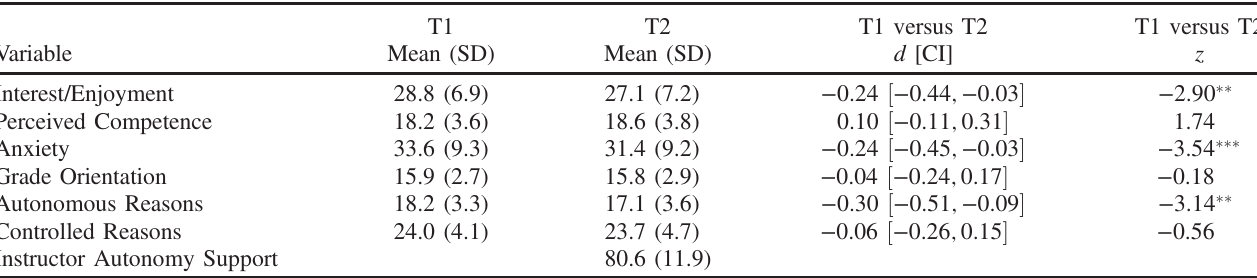
TABLE II. Mean values of key variables measured at the beginning of the course (T1) and end of the course (T2) for all students combined ( N ¼ 182 ), Cohen ’ s d and 95% confidence interval for T2 minus T1, and Wilcoxon signed-rank test z statistic for T2 versus T1 ( (cid:2) p < 0 . 05 , (cid:2)(cid:2) p < 0 . 01 , and (cid:2)(cid:2)(cid:2) p < 0 . 001 ). We see that on average students became less interested in learning physics, became less anxious about studying physics, and came to study physics for less autonomous reasons over the duration of the course.